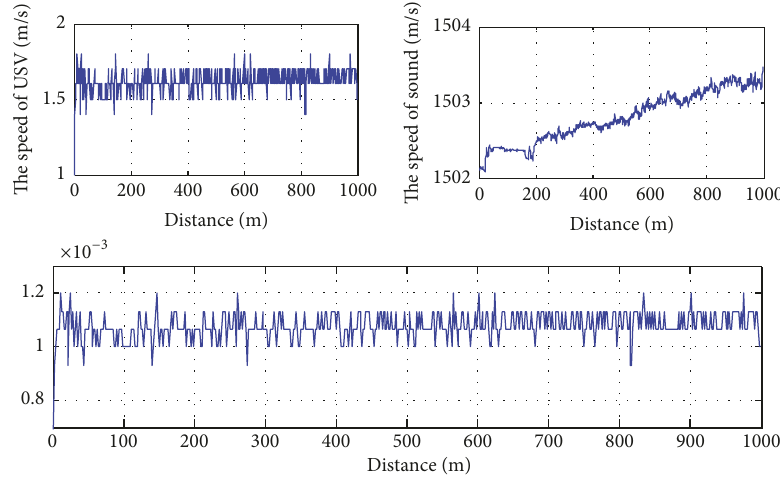
Figure 1: USV speed/sound speed/Doppler